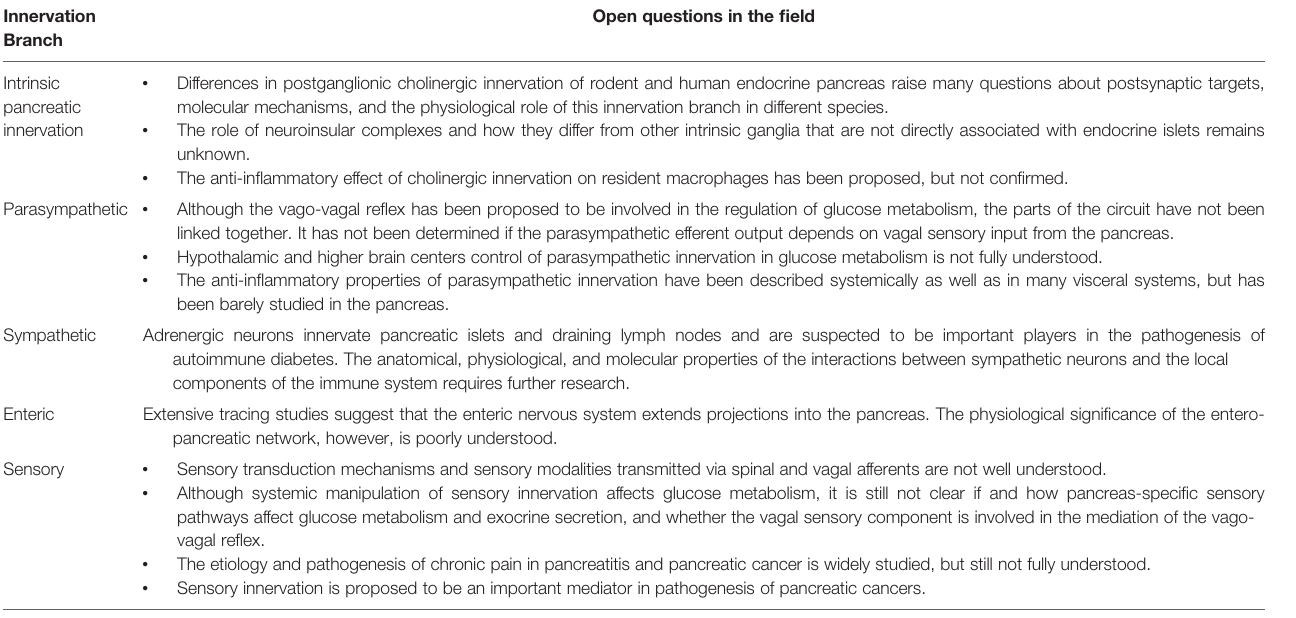
TABLE 1 | Open questions in the fi eld of pancreatic